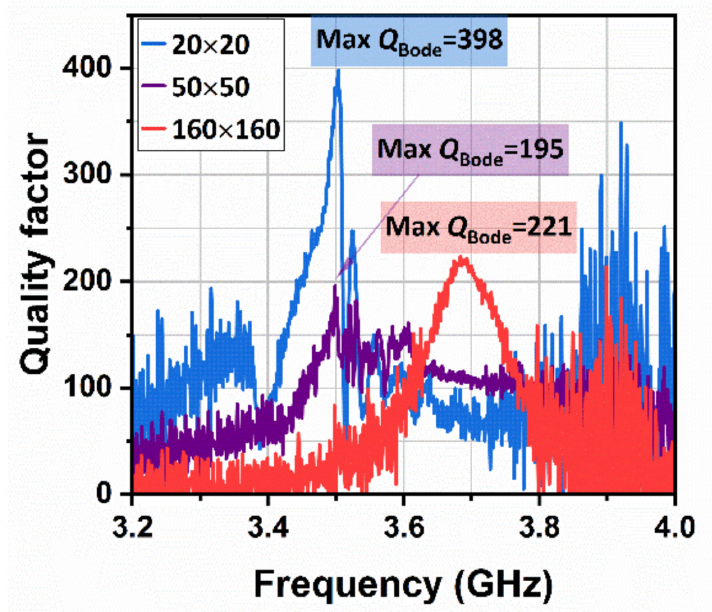
Figure 4. Bode Q frequency response curves with different